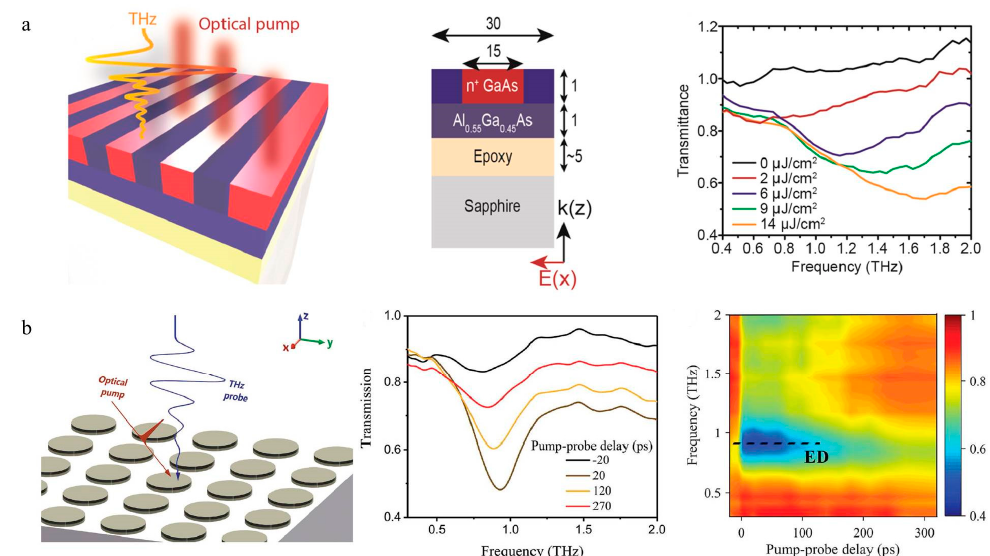
Figure 6. ( a ) Schematic of the optical-induced transient GaAs metasurface and the dimensions of the structure. The transmission coefficient of the THz wave declines with increasing pump fluence in the experiment. Reproduced with permission from [45], copyright American Chemical Society, 2017. ( b ) Structure of the tunable plasmonic metasurface. The figure on the right shows the experimental transmission spectra and transient transmission map of the plasmonic metasurface with different pump probe delay values. Reproduced with permission from [47], copyright John Wiley and Sons, 2018.